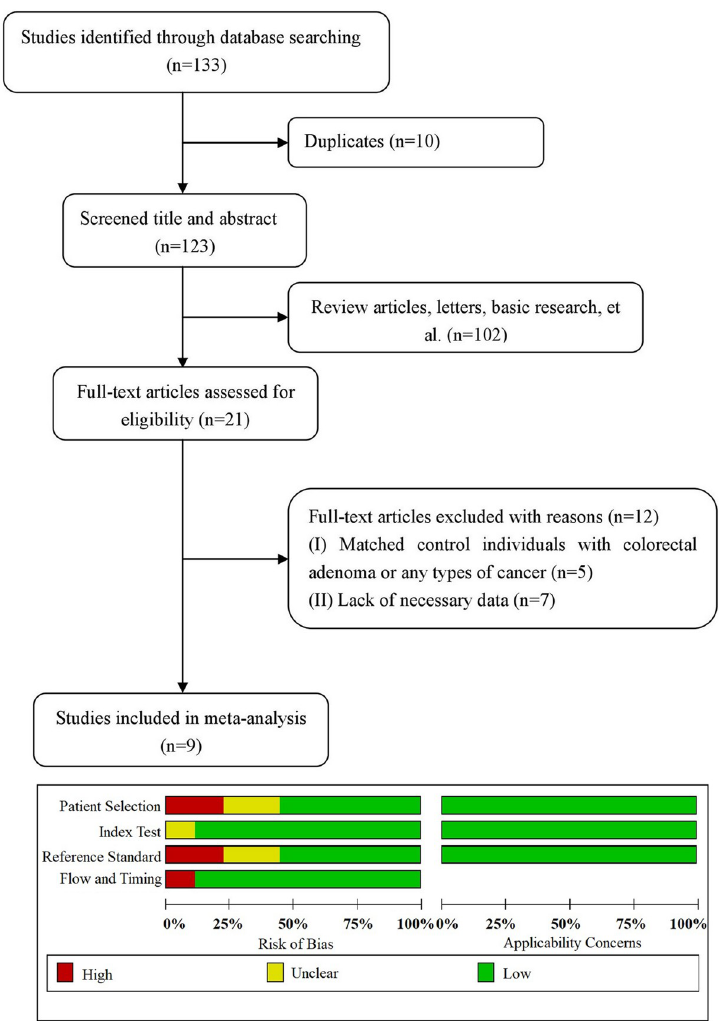
Fig 1. Flow diagram for the study selection process and quality assessment using QUADAS-2. The quality of each eligible study was assessed by QUADAS-2. It summarized ‘‘risk of bias” and ‘‘applicability concerns” through judging each domain for each included